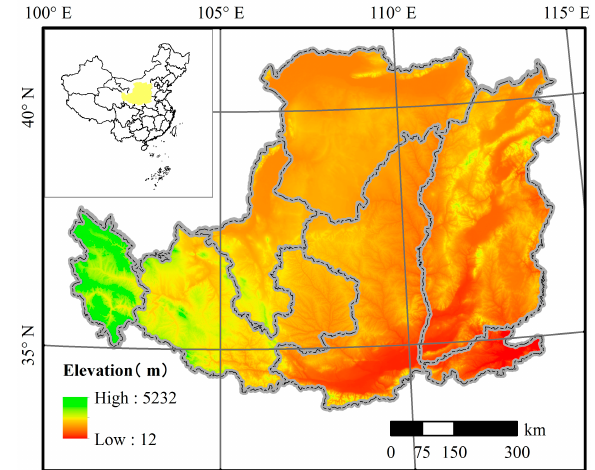
Figure 1. Digital elevation map of the Loess Plateau. The inset shows the location of the Loess Plateau in China.